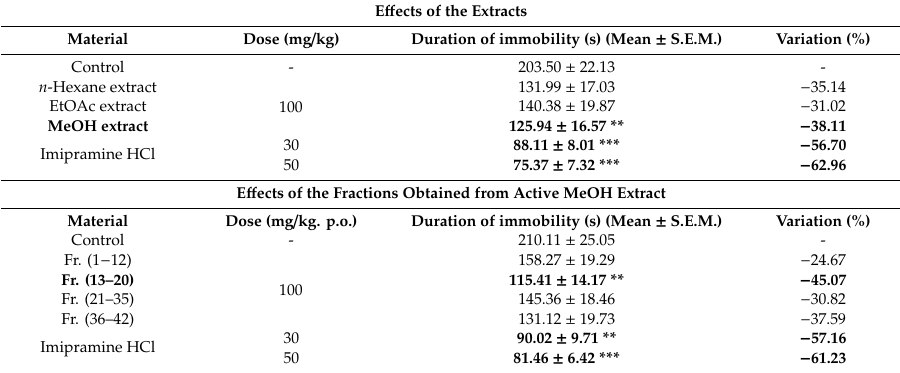
Table 3. E ff ects of the extracts and fractions prepared with organic solvents from Lotus corniculatus L. subsp. corniculatus in the tail suspension test.